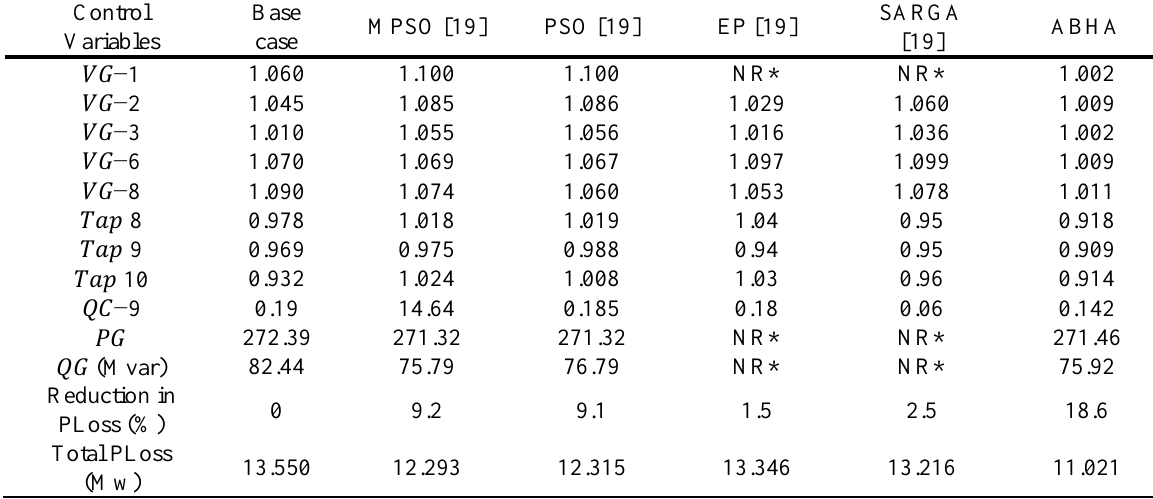
Table 3. Simulation results of IEEE −14